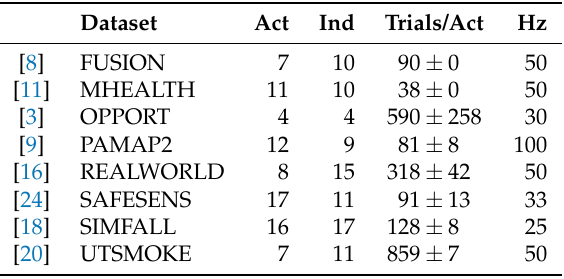
Table 1. Number of (act)ivities and (ind)ividuals, trials/activity (±standard error), and sampling frequency (Hz) for each of the